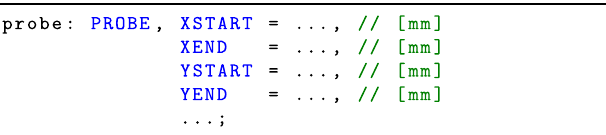
FIG. 11. OPAL input command for probe